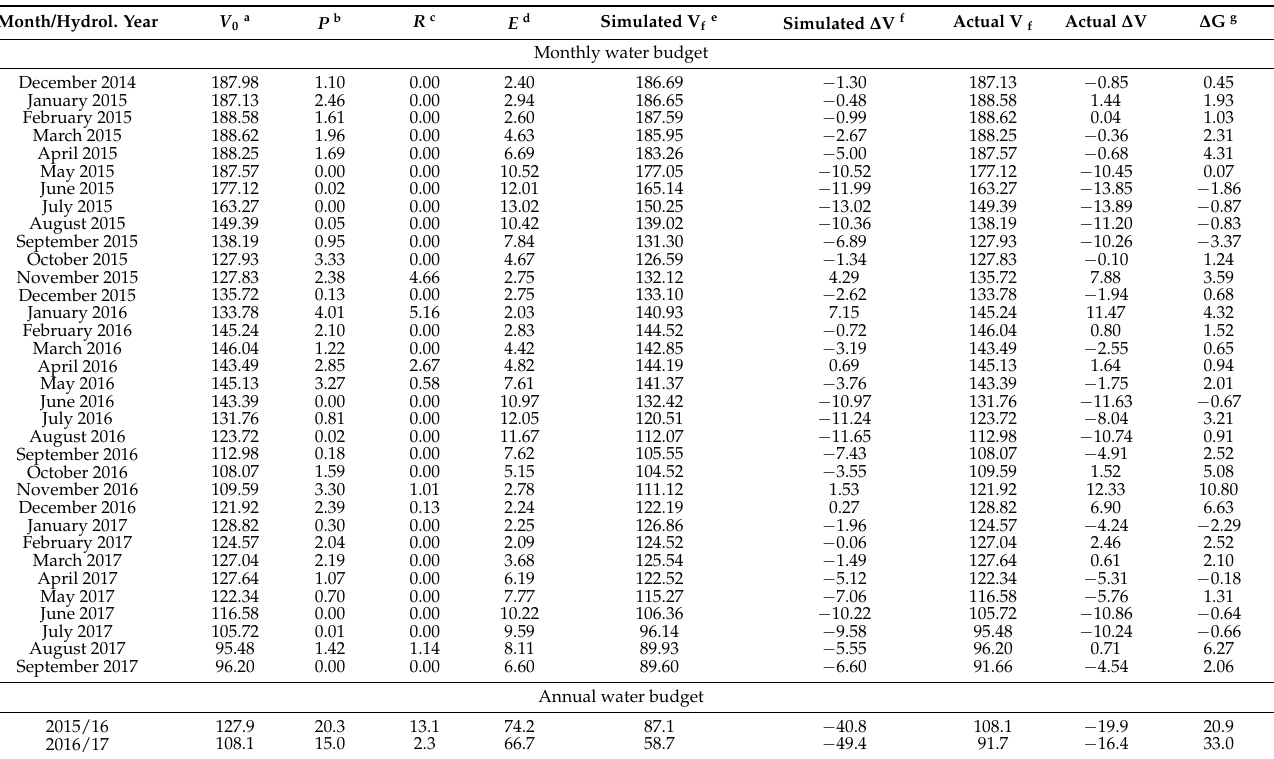
Table 3. Monthly and annual water budgets of the Amarga wetland in the study period. Units in dam 3 . Month/Hydrol.